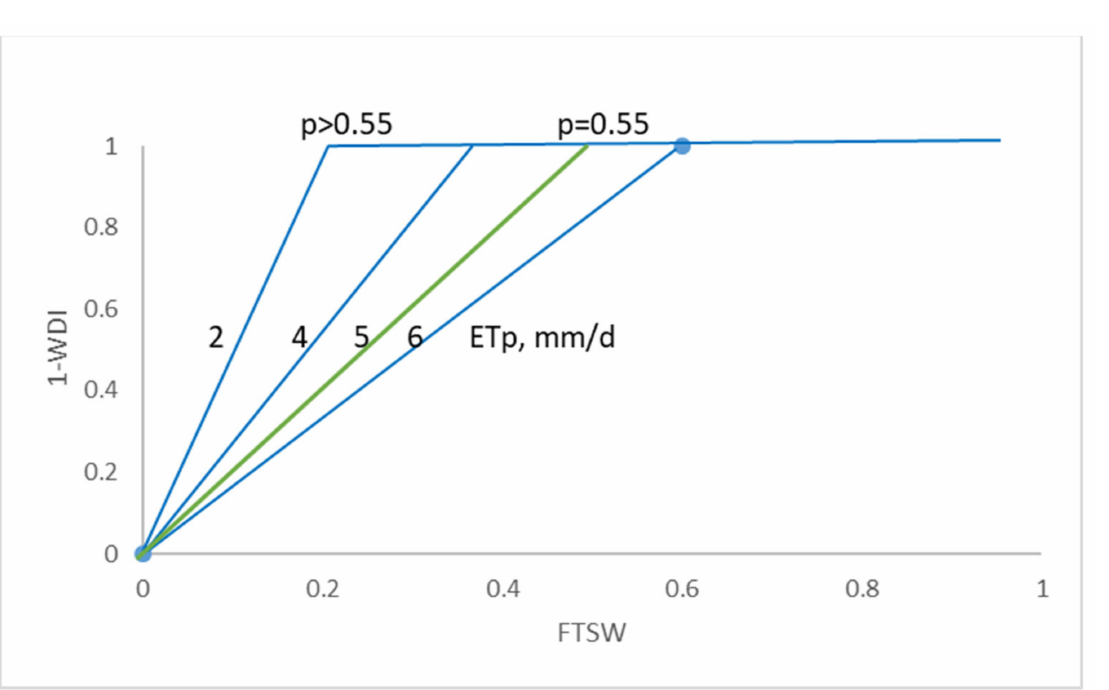
Figure A4. Simplified illustration of the relationship between the fraction of transpirable soil water and relative actual evapotranspiration (1- WDI ) depending on the level of potential evapotranspiration ( ETp ) and fraction of available soil water that can be depleted before drought stress occurs ( p ). WDI is the Water Deficit Index calculated according to Equation (1) (see Section